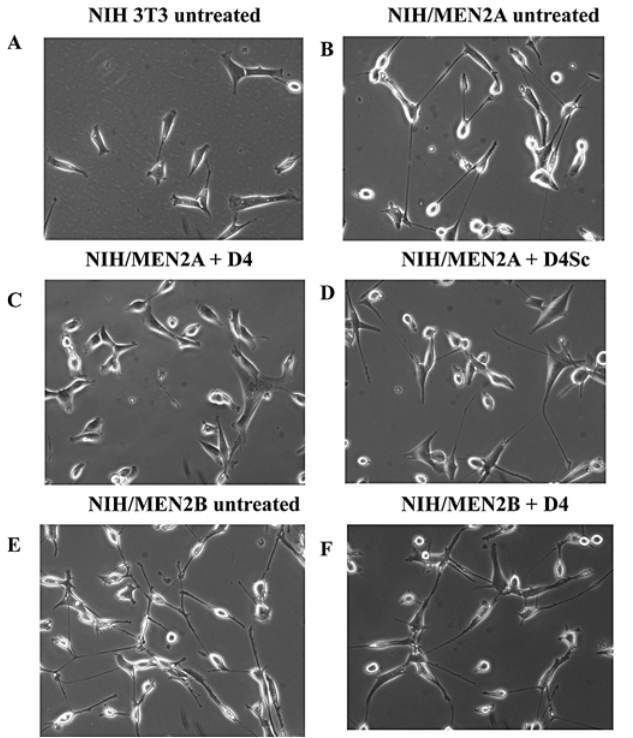
Figure 6. D4 Aptamer Reverts the Transformed Morphology of NIH/ MEN2A Cells NIH3T3-derived cell lines were either left untreated (A, B, and E) or treated with D4 (C and F) or D4Sc (D), and the cells were maintained in culture for 72 h. Each experiment was repeated a minimum of three